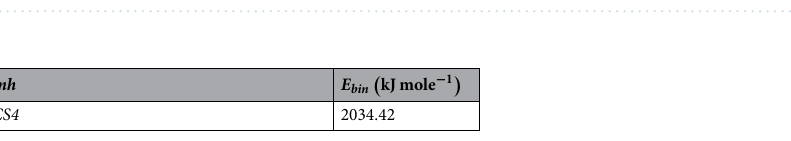
Table 7. Binding energies of the studied CS4 adsorbed on Fe (110)